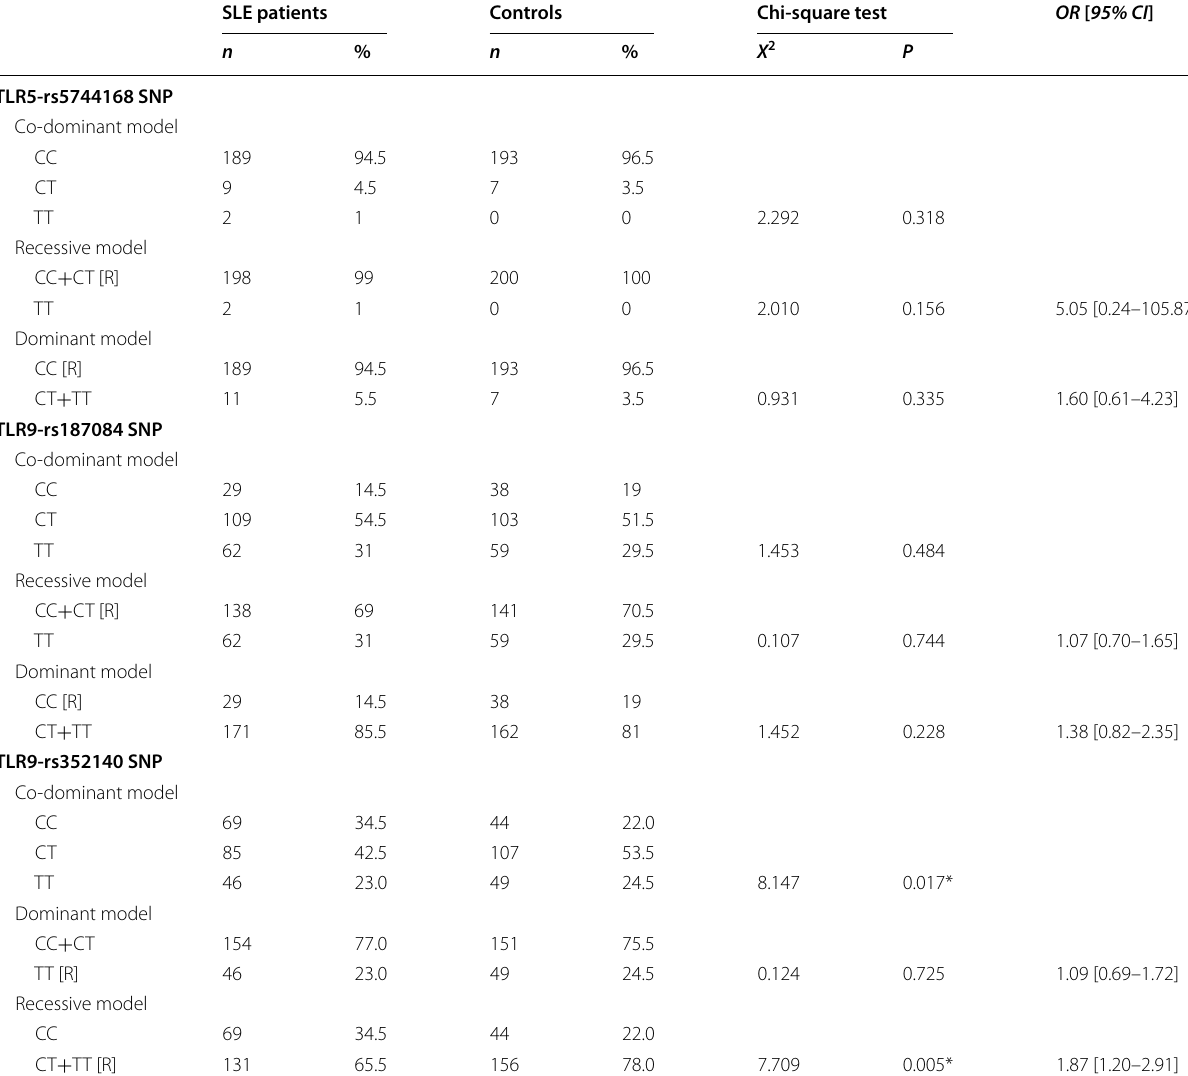
Table 2 Comparison of genotyping distribution of TLR9 gene SNP rs187084 and TLR5 gene SNP rs5744168 between SLE patients and